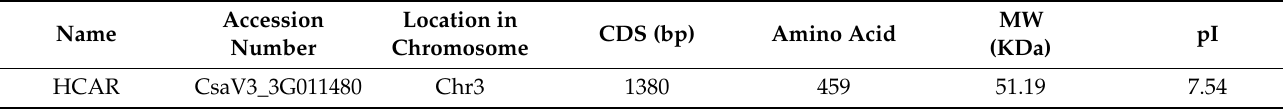
Table 1. Properties of the cucumber